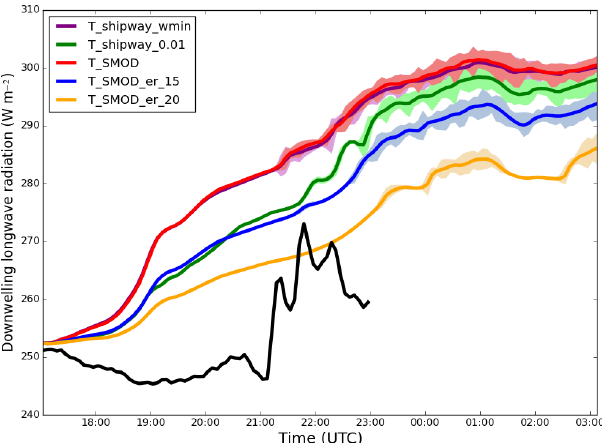
Figure 8. Time series of the downwelling longwave radiation (Wm − 2 ) at a 2m altitude. Purple – T_shipway_wmin; green – T_shipway_0.01; red – T_SMOD; blue – T_SMOD_er_15; orange – T_SMOD_er_20; black – observations. The minimum and maxi- mum downwelling longwave radiation are marked on the figure by the shaded